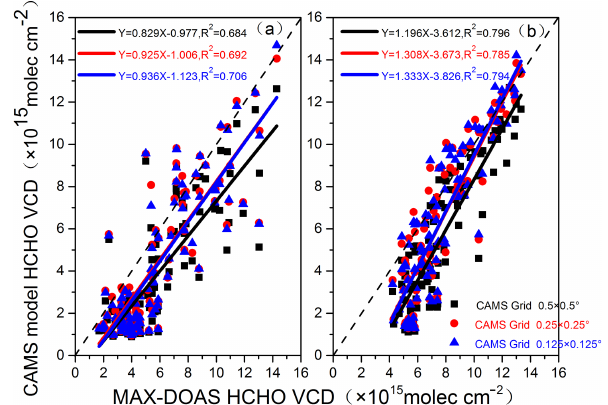
Figure 16. Correlation between HCHO VCDs retrieved from the MAX-DOAS measurements and those obtained from the CAMS model at 08:00LT (a) and 14:00LT (b) from October to Decem- ber 2014 in different